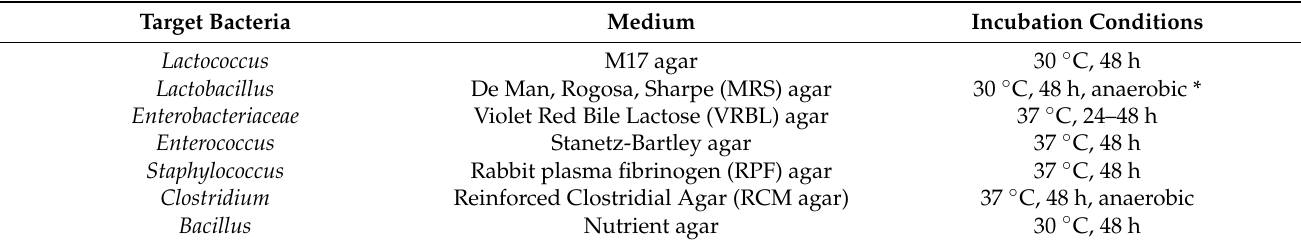
Table 2. Culture media and incubation conditions applied in the